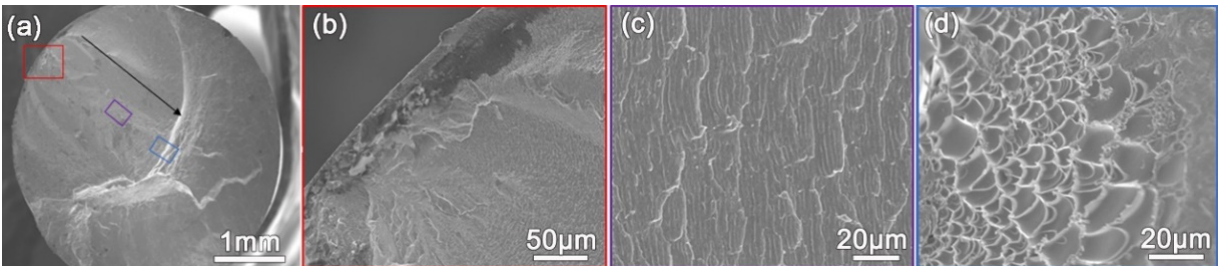
Figure 3 . Fracture surface of the Zr 61 Ti 2 Cu 25 Al 12 BMG tested at the stress amplitude of 460 MPa. ( a ) Overview of the fracture surface. The black arrow shows the direction of fatigue crack propagation. Details in the red, purple, and blue box are shown in ( b – d ), respectively. ( b ) Initiation site of the fatigue crack. ( c ) Fatigue striations formed during fatigue crack propagation. ( d ) Dimples generated during catastrophic fracture.